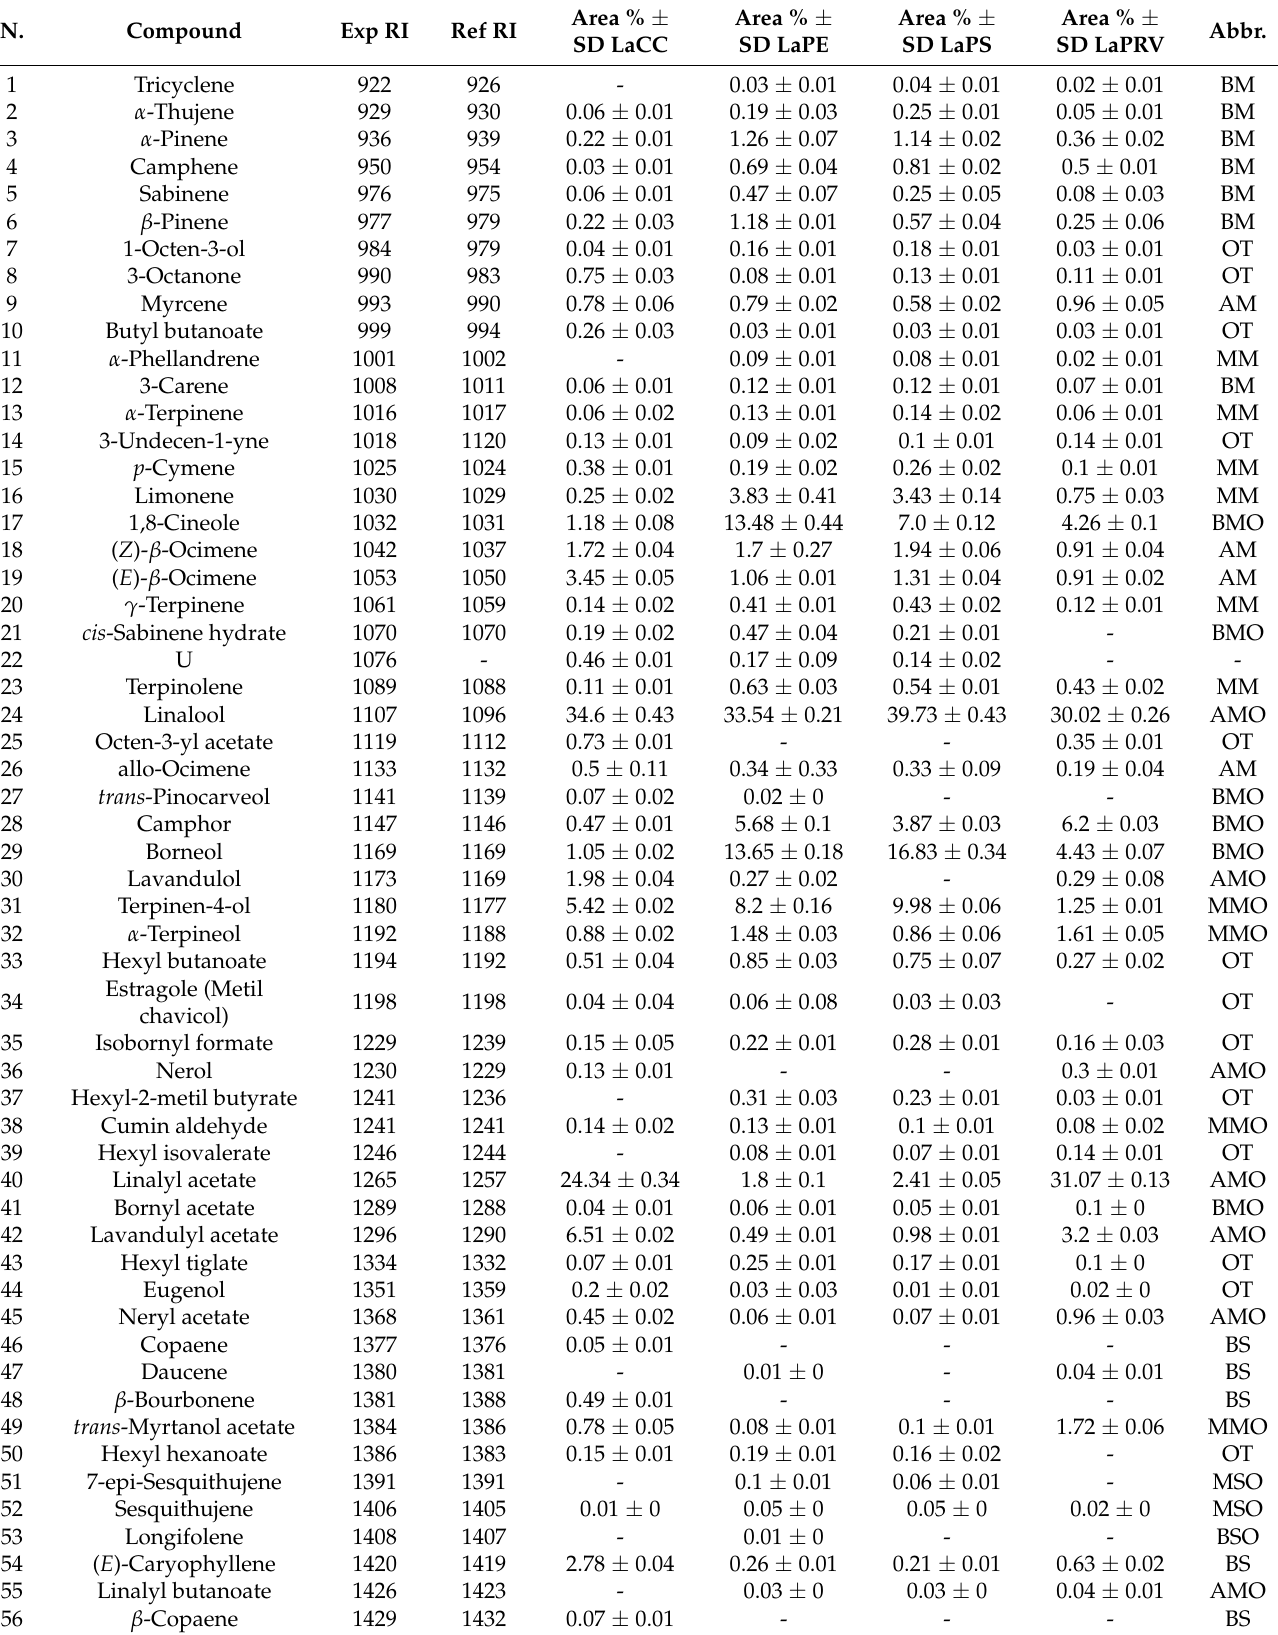
Table 1. Chemical composition of EOs extracted from L. angustifolia